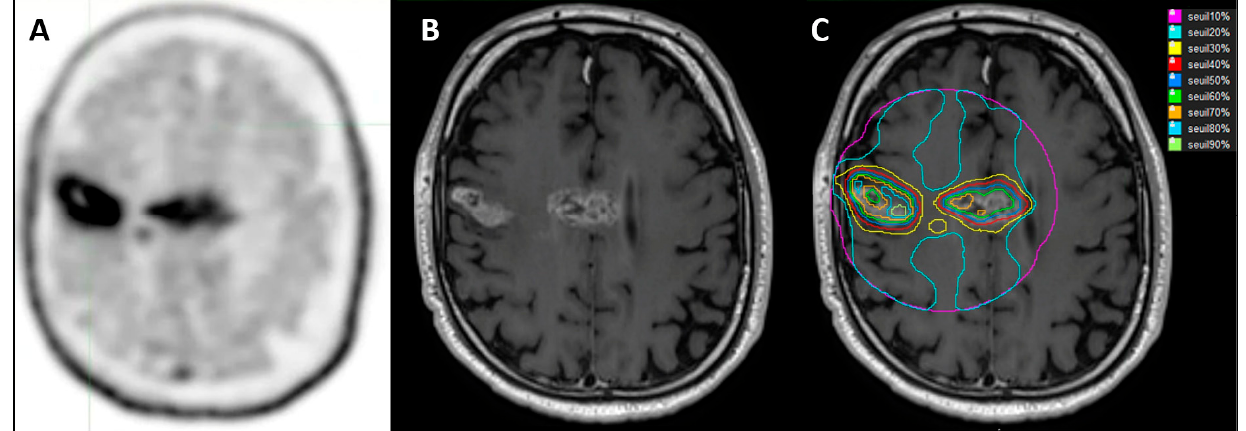
Figure 3. A 68-year-old patient with multifocal glioblastoma in the right frontal area and corpus callosum. ( A ). FET PET after surgical biopsy and before RT-CT. ( B ): NADIR MRI (MRI 2) after RT-CT in T1-GD sequence 3 months after FET PET. ( C ): Different SUVmax thresholds on MRI 2 after co-registration.